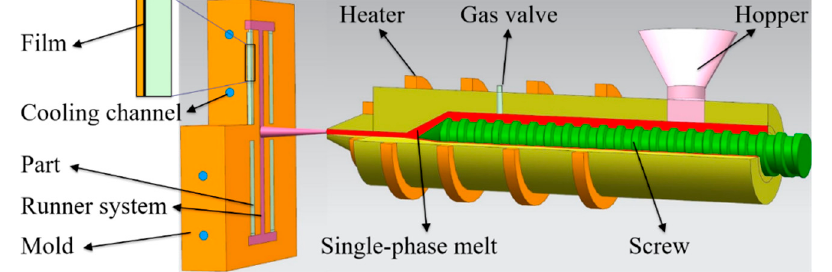
Figure 1. The process of IMD/MIM.